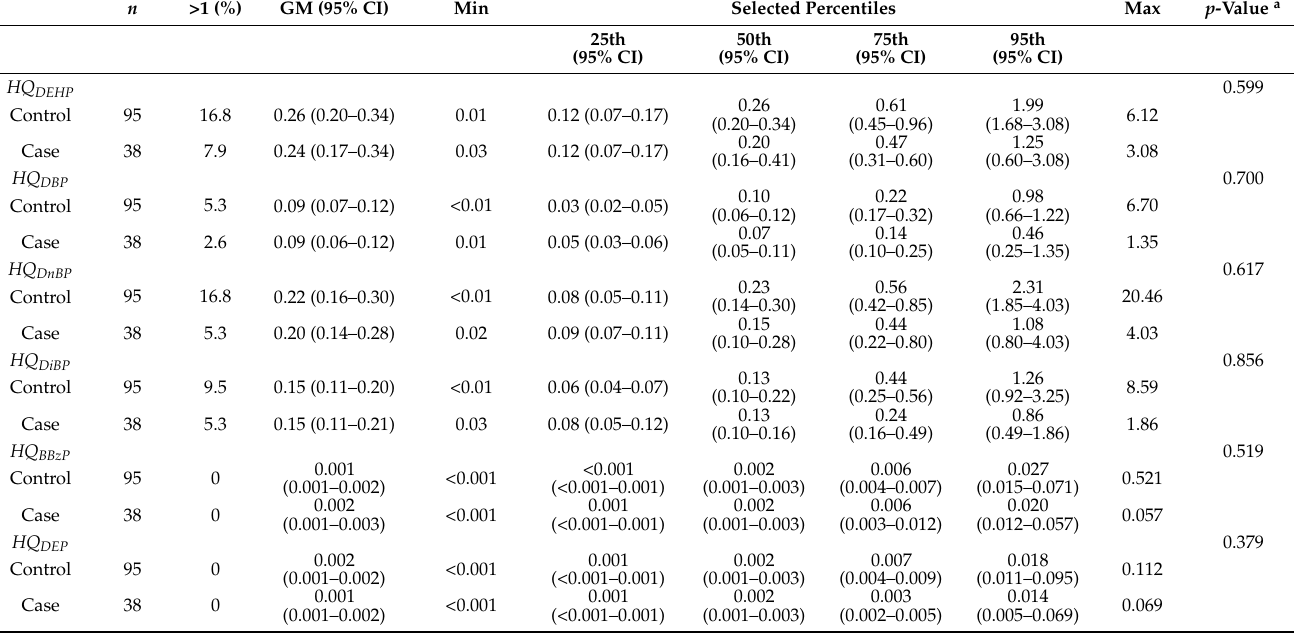
Table 5. Hazard quotients and hazard index by tolerable daily intake for control and case